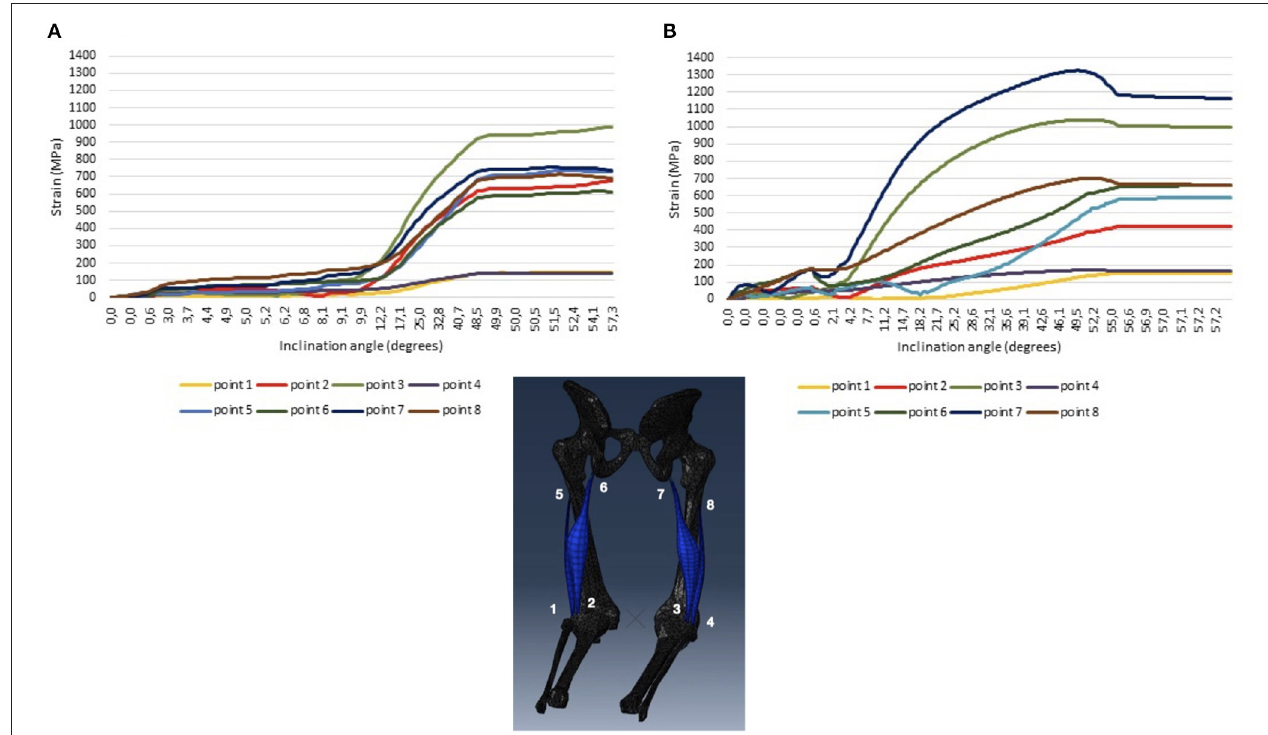
FIGURE 1 | Strain forces acting on the biceps femoris muscle long and short heads during movement with lumbo-pelvic complex rotation in relation to body axis 0.1 radian (A) and 0.4 radian (B)